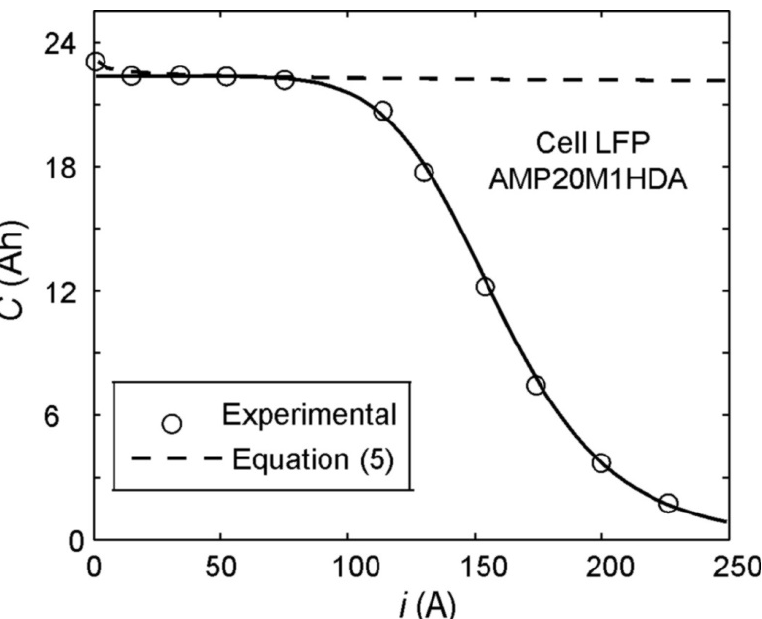
Figure 1. Comparison between experimental data for lithium-ion batteries and Peukert Equation (5). It is fundamentally important that the experimental function C ( i ) for the lithium-ion batteries has three absolutely different sections (Figure 1). The first section of function C ( i ) is located at the currents from zero to the first curve inflection point (approximately 50 A).